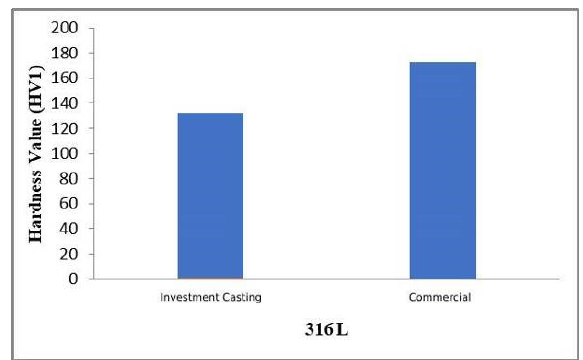
Figure 4. Hardness values of 316L